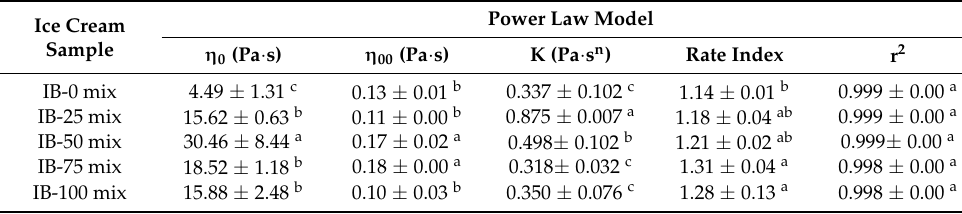
Table 8. Rheological properties (mean ± SD) of ice cream incorporating